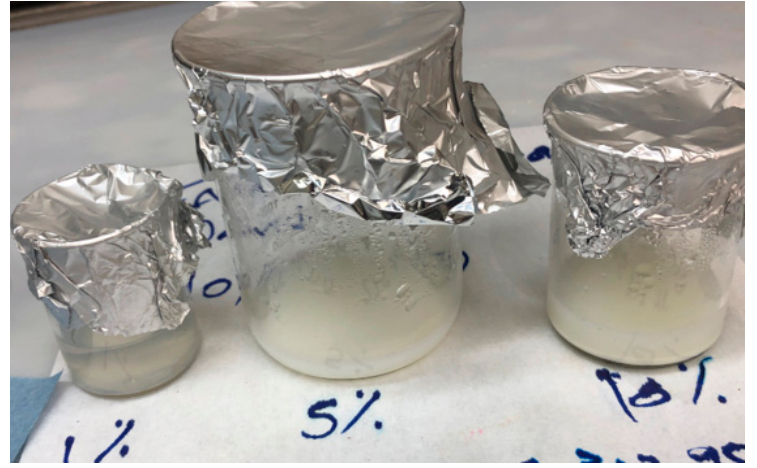
Figure 4. After heating while magnetic stirring, and then sonication of the three different ZnO concentrations.